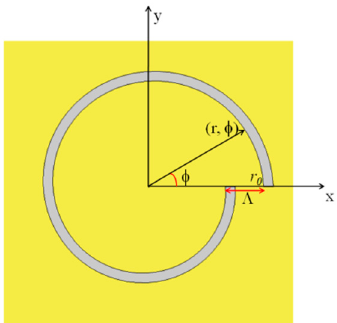
Figure 1. Schematic diagram of a single-turn left-handed Archimedes’ spiral slit (ASS) etched though a thin gold film.